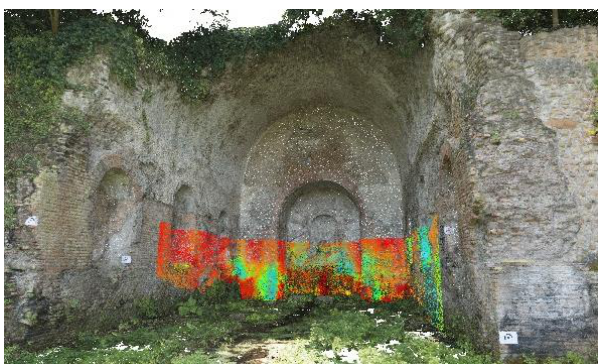
Figure 7. RGB point cloud integrated with IRT data The examination of metric reliability of the projection centres and of their right positioning occurred by relating the overlapping between the cloud, the RGB image and the thermal image. The operation was carried out on pairs of sample frames with a good recognisability of common characteristic points (Fig. 8, Fig 9). In this way, we had the chance to verify the extension of the translation of the sensor along the z axis, the correspondence between the two images of the pair and how much reliable was the level of reprojection.